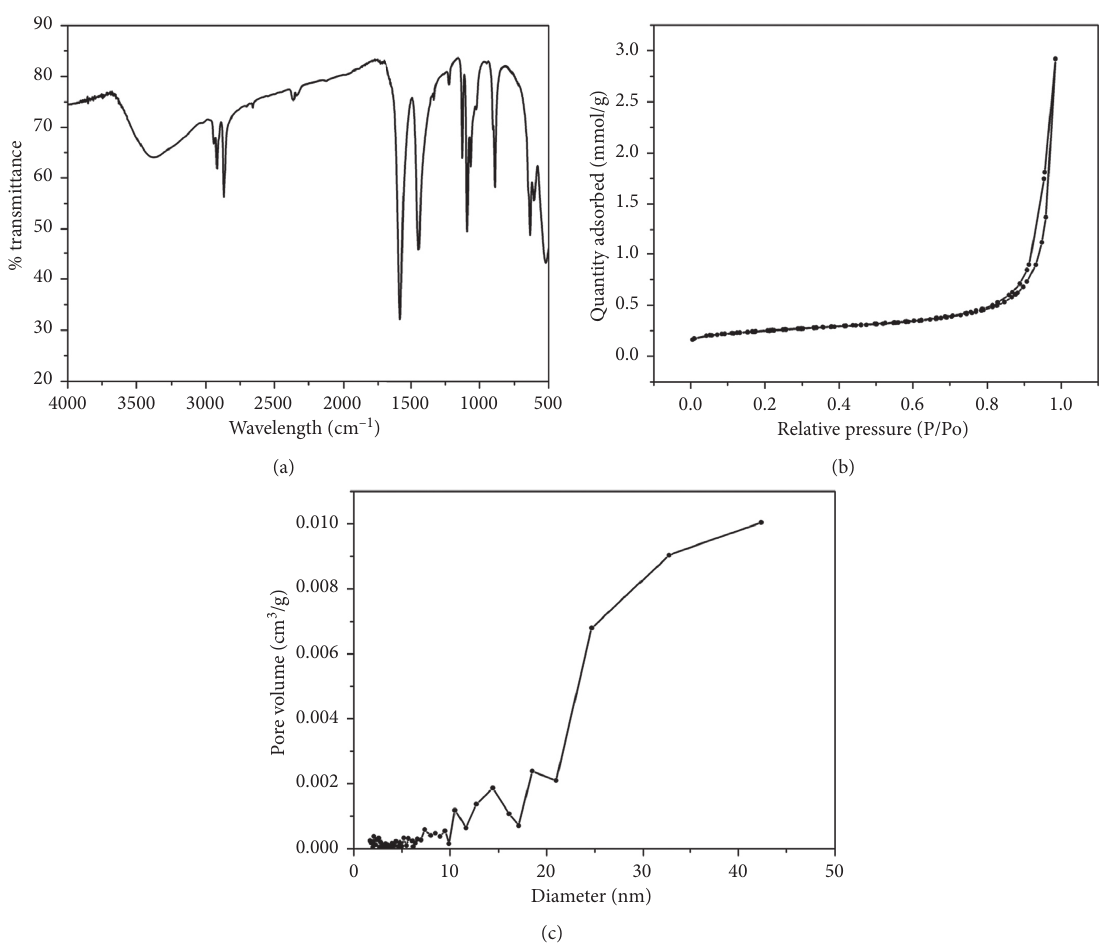
Figure 2: (a) FT-IR spectra of the magnetic nanoparticles (Fe 3 O 4 NPs) and the magnetic nanoparticle-loaded alginate beads. (b) The adsorption-desorption isotherm and pore size distribution (inset) of the magnetic nanoparticle-loaded alginate